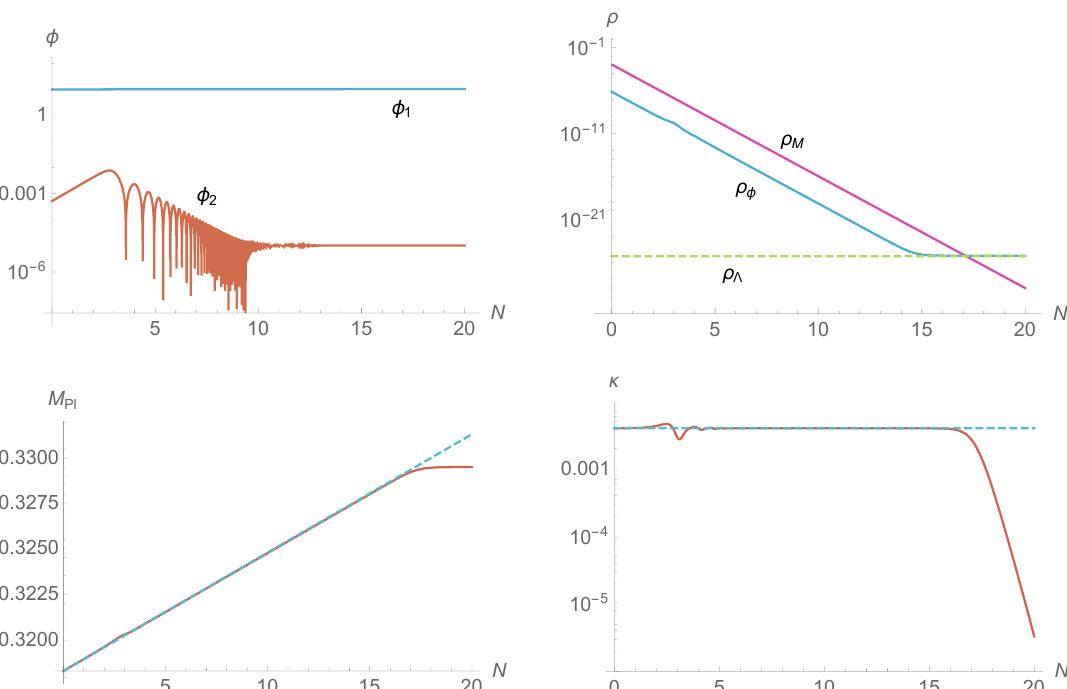
Figure 2 . A numerical study of the cosmological solutions of the scale invariant model (4.1) with a cold matter component ( ! = 0). Top-left: the evolution of (cid:12)elds (cid:30) 1 (blue) and (cid:30) 2 (red). Top- right: the evolution of the energy densities of the scalar (cid:12)eld (cid:26) (cid:30) (red), cold matter (cid:26) M (blue) and cosmological constant (cid:26) (cid:3) from the scalar (cid:12)elds (4.4) (green). Bottom-left: the numerical evolution of the Planck mass (solid line) compared to the analytic approximation M 2 / exp (cid:20) evaluated for the matter dominated epoch (dashed line). Bottom-right: the numerical evolution of the (cid:20) parameter (solid line) compared to its analytic approximation (3.13) evaluated for the matter dominated epoch (dashed line). Parameters used for the plot: (cid:21) 11 = 10 (cid:0) 25 , (cid:21) 22 = 0 : 1, (cid:21) 12 = (cid:0) 0 : 9999 (cid:2) 10 (cid:0) 13 , (cid:24) 1 = 10 (cid:0) 3 , (cid:24) 2 = 0 : 9. The horizontal axis denotes time in e -folds, N = ln a